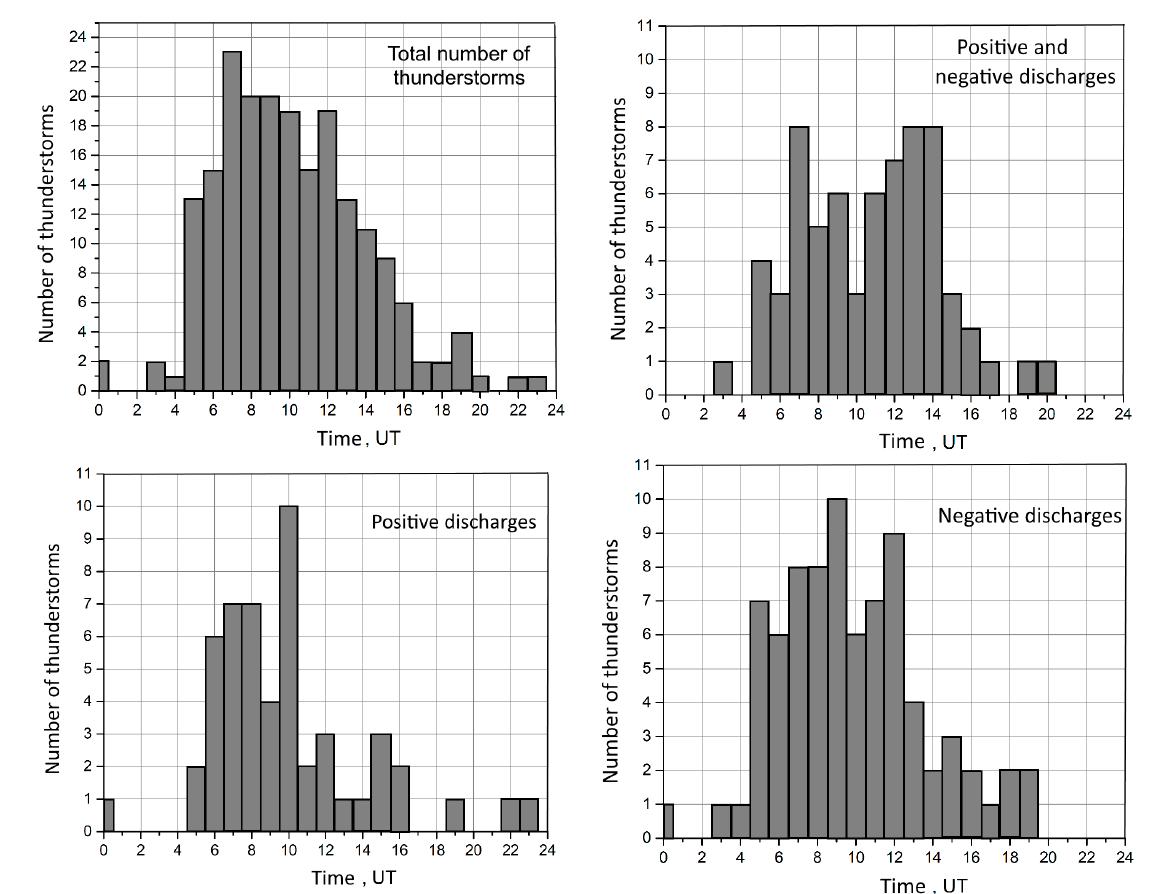
Figure 3. Diurnal distribution of thunderstorms at the high-mountain Tien-Shan station for various types of lightning discharges.